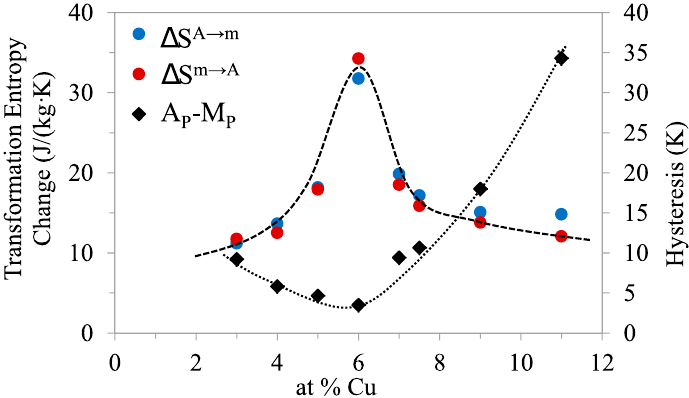
Figure 4. Absolute values of the transformation entropy changes, for the forward and reverse MTs, together with the thermal hysteresis computed as Δ T = A P − M P , as a function of Cu content.